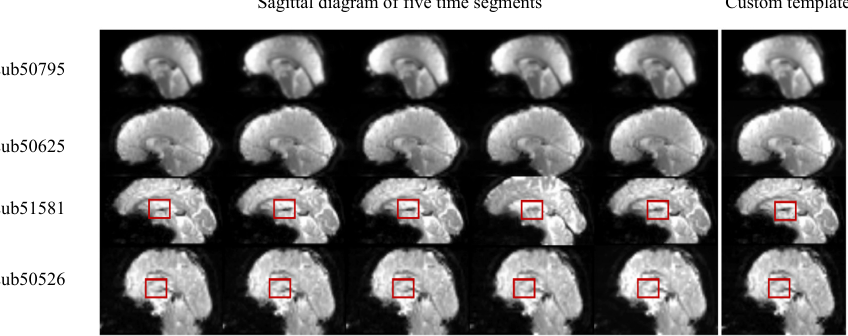
Figure 7. Display of customized templates for different